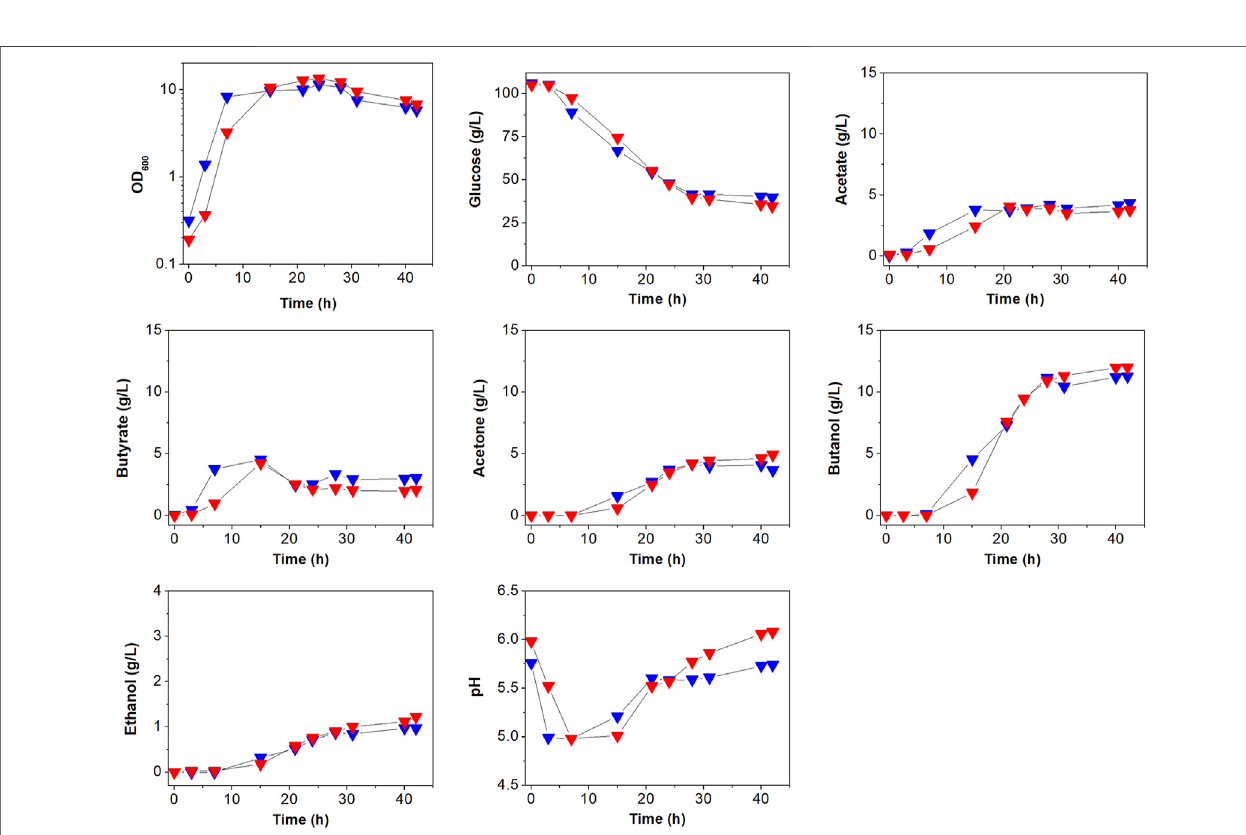
FIGURE 3 | Comparison of batch fermentation pro fi les between C. acetobutylicum ATCC 824 (blue) and its mutant 824-2866KD (red). Fermentation parameters arecellgrowth(OD 600 )glucoseconsumption,acids(acetateandbutyrate)production,andsolvents(acetone,butanol,andethanol)production.Mergedversionofbatch fermentation pro fi les of C. acetobutylicum 824-2866KD are shown in Supplementary Figure S3A . Other reproduced bioreactor cultivation pro fi les are shown in Supplementary Figure S3B